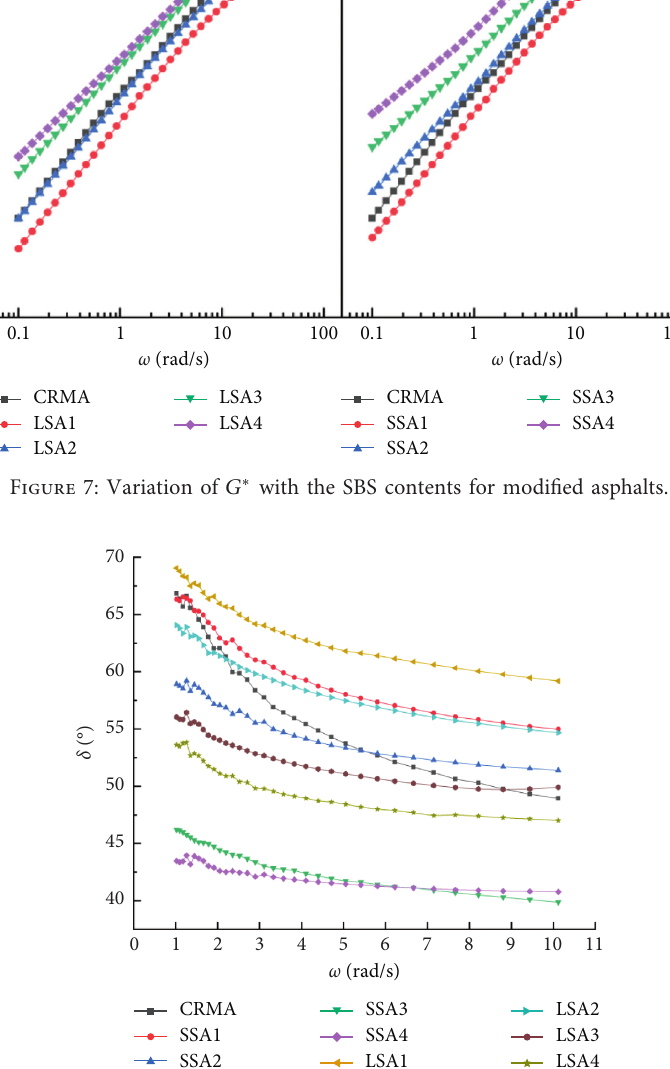
Figure 8: Variation of δ with the SBS contents for modified